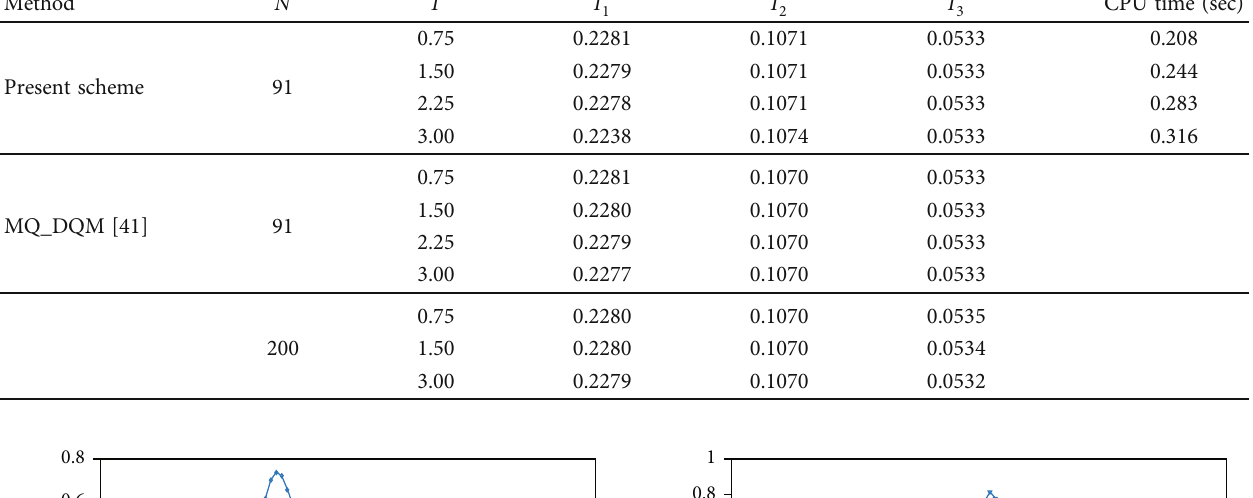
Table 4: Experimental evaluation of interaction of two solitons: Δ t = 0 : 005 :